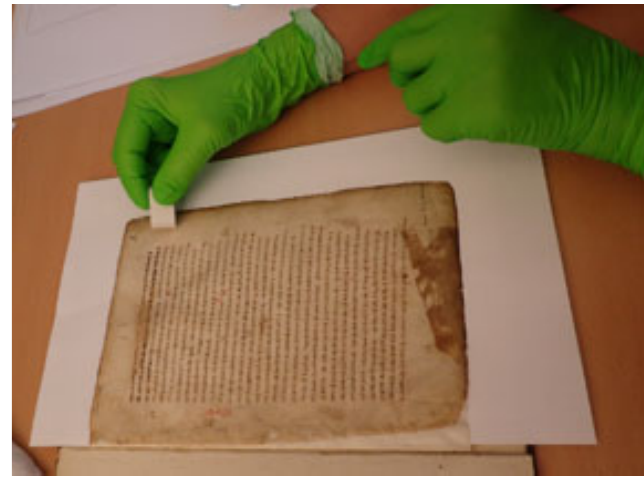
Figure 4. Sampling of an ancient parchment manuscript using PVC erasers by gently rubbing the frame of the manuscript.